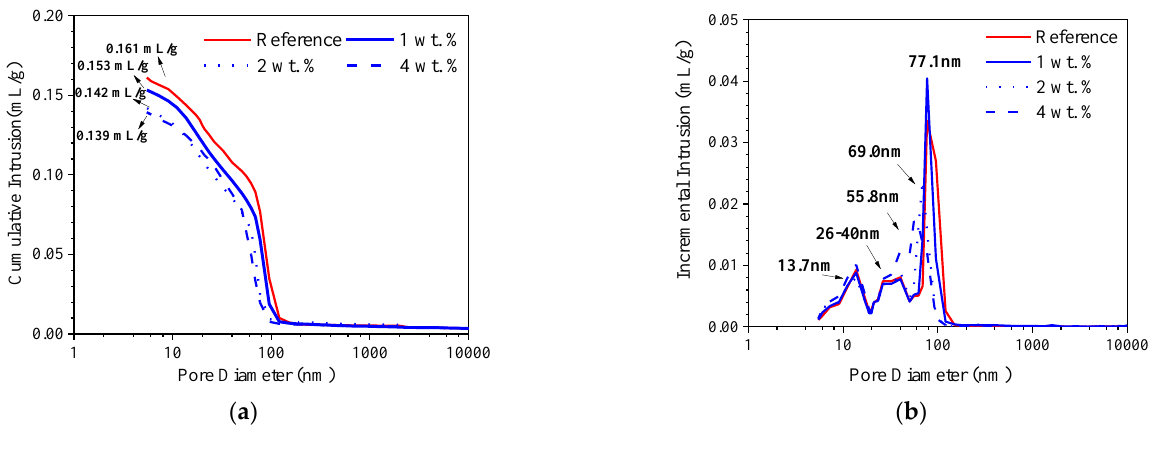
Figure 4. Total porosity ( a ) and pore size distribution ( b ) of cement paste with different dosages of hydrophobic functional corrosion inhibitor at 28 days of curing. Table 8. The pore volume at different pore size ranges for cement paste in the presence of hydrophobic functional corrosion inhibitor with different concentrations at 28 d of